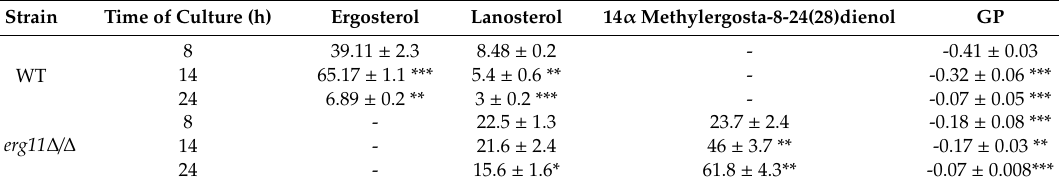
Table 2. Sterols ( µ g / mg dry mass of isolated lipids, means ± SD, n = 3) in C. albicans CAF2-1 (WT) and KS028 ( erg11 ∆ / ∆ ) strains. Statistical analysis was performed in accordance to µ g / mg values after 8 h of culture (**, p < 0.01; ***, p < 0.001); General polarization values (GP; means ± SD, n = 6) of Laurdan incorporated into plasma membranes of C. albicans CAF2-1 (WT) and KS028 ( erg11 ∆ / ∆ ) strains. Statistical analysis was performed in accordance to GP values after 8 h for the WT strain (**, p < 0.01; ***, p <